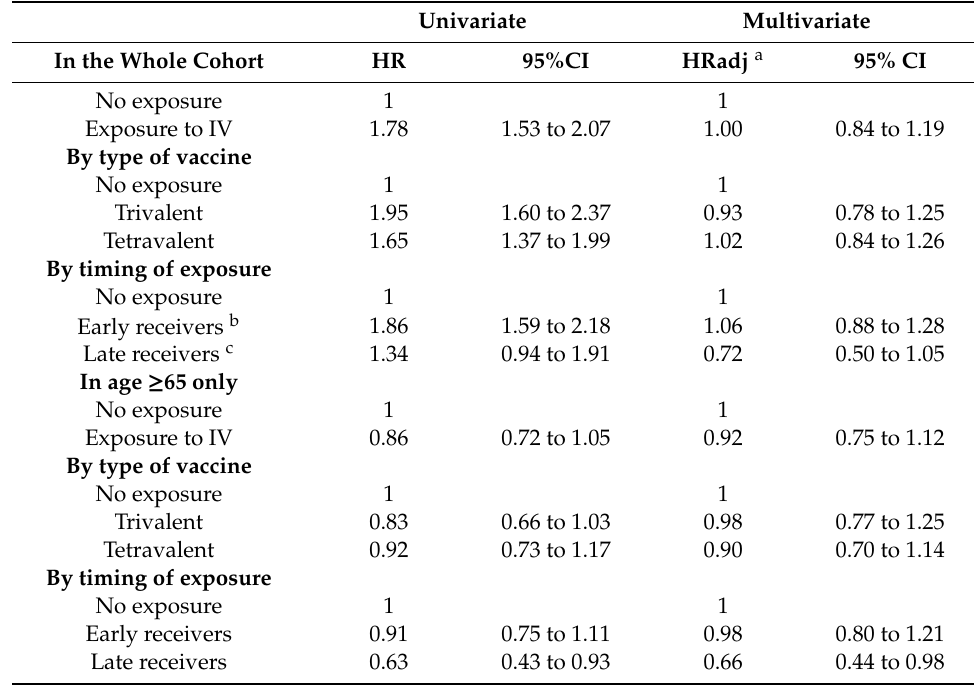
Table 6. Results of univariate and multivariate analyses on time from diagnosis to hospital admission, according to previous exposure to influenza vaccination (IV), in the whole cohort of covid-19 patients and in the age > 65 years subgroup. Secondary analyses in gray